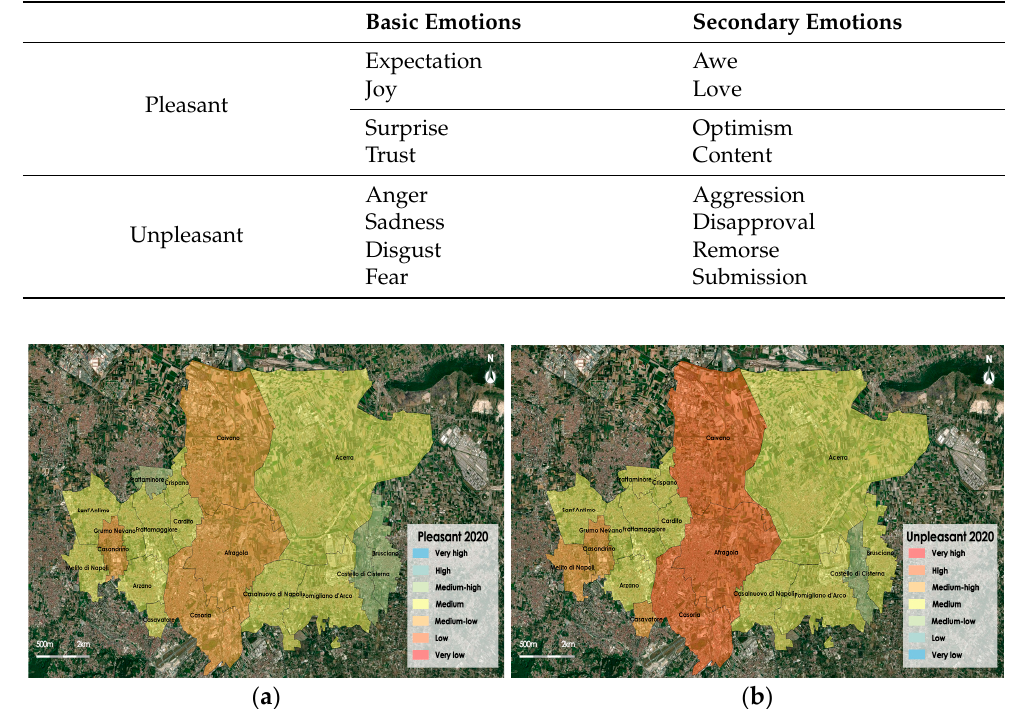
Table 1. Pleasant and unpleasant emotional categories.